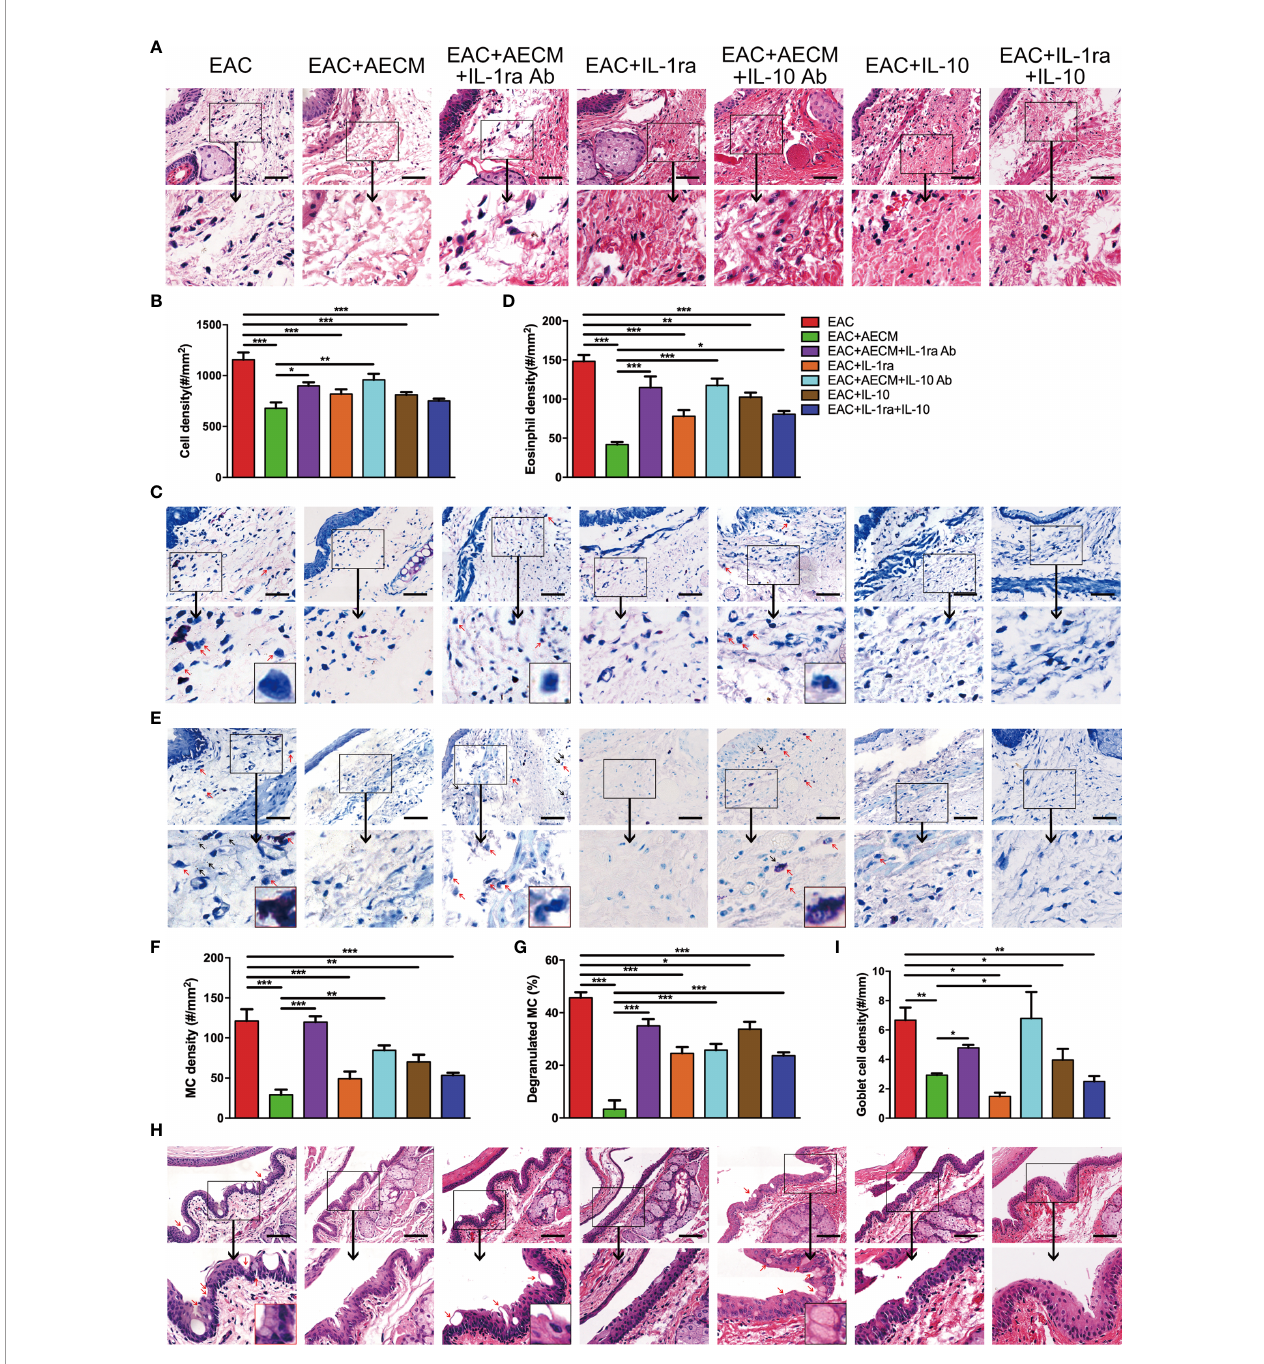
FIGURE 8 | Anti-in fl ammatory factor IL-1ra and IL-10 are necessary for AECM-mediated reduction on the in fl ammation response in EAC mice. (A) Representative image of H&E staining of the conjunctiva of mice in different treatment groups. Scale bar, 50 m m. (B) Quanti fi cation of cell density in the conjunctiva of mice in different groups. The data are expressed as the mean ± SEM. At least six representative sections of the conjunctiva were counted. At least three mice were used in each group. (C) Giemsa staining of conjunctiva of mice in different treatment groups. Red arrows indicate eosinophils. Scale bar, 50 m m. (D) Quanti fi cation of eosinophil density in the conjunctiva of mice in different groups. (E) Representative images of toluidine blue staining of MCs in the conjunctiva of mice in different groups. Scale bar, 50 m m. (F, G) Quanti fi cation of the MC (F) and degranulated MC (G) in the conjunctiva of mice in different groups. (H) H&E staining of the conjunctiva of mice in different treatment groups. Red arrows indicate goblet cells with vacuole. Scale bar, 100 m m. (I) Quanti fi cation of goblet cell density in the conjunctiva of mice. * P < 0.05, ** P < 0.01, and *** P <